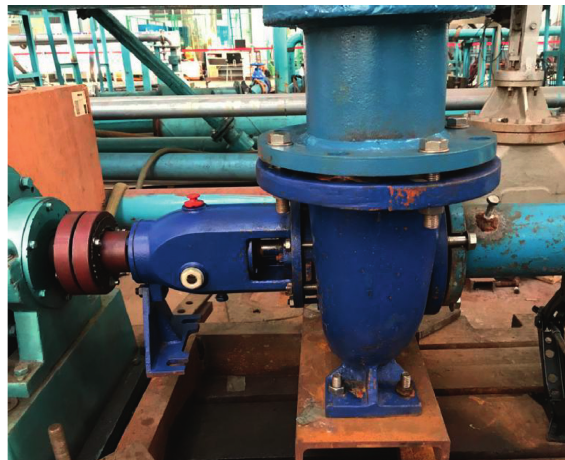
Figure 9: Experimental test of external